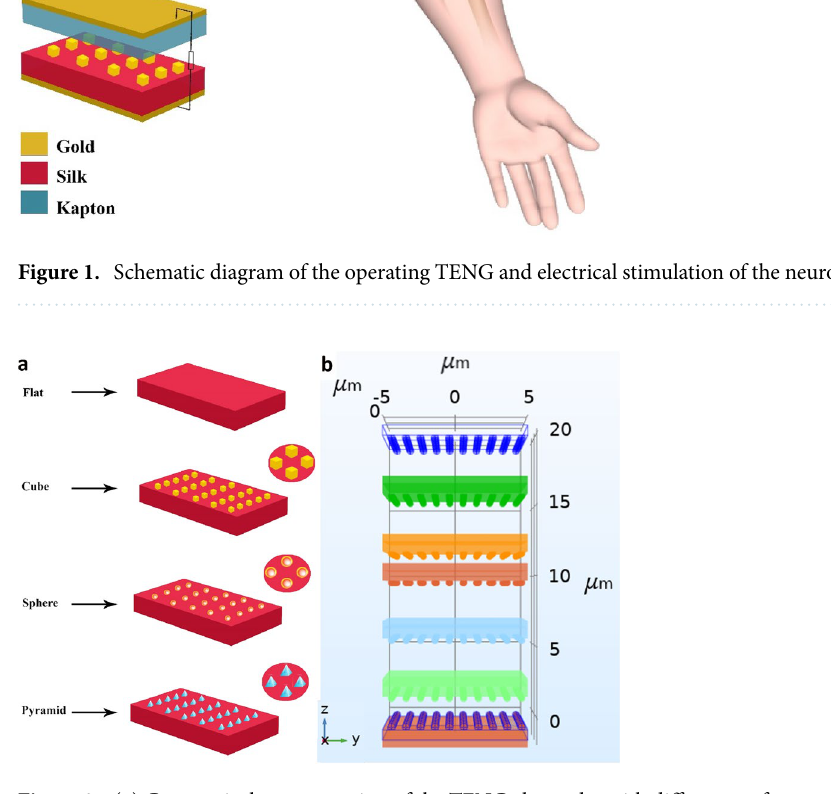
Figure 2. ( a ) Geometrical representation of the TENG electrodes with different surface modifications. ( b ) Representation of the computational model in the COMSOL environment for calculation of capacitance and charge for different distances between the TENG’s